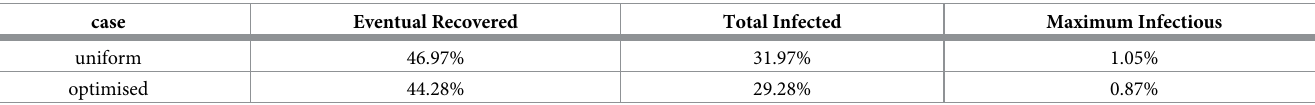
Table 4. Difference between the case in which 15% of each age-group in the population of Germany is vaccinated and the optimised case, in which different fractions of each age-group are vaccinated, but 15% of the population in total. The population is assumed to be under a containment policy that keeps R 0 =